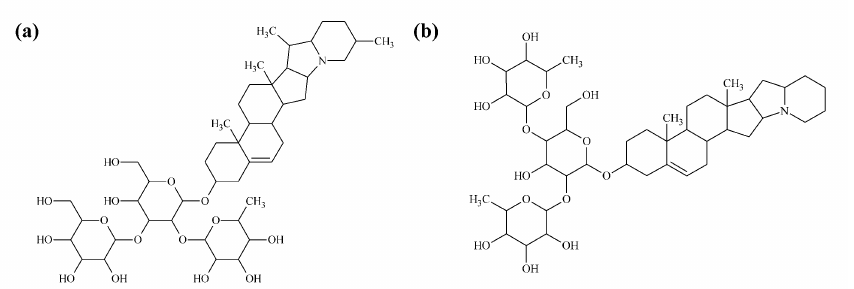
Figure 8. Chemical structures of two common glycoalkaloids in potato. ( a ) Solanine and ( b )